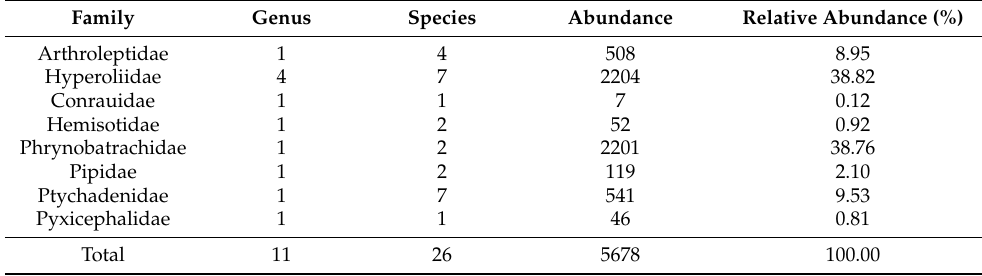
Table 3. Species and genus composition, abundance and relative abundance among families in